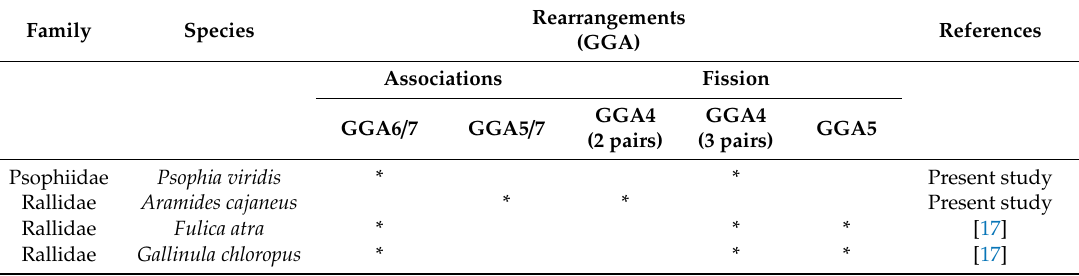
painting with G. gallus